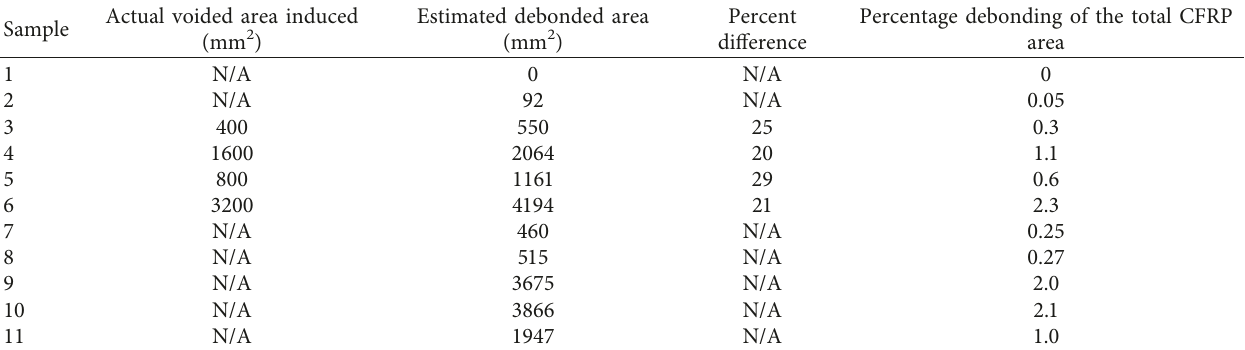
Table 6: Total delaminated areas due to